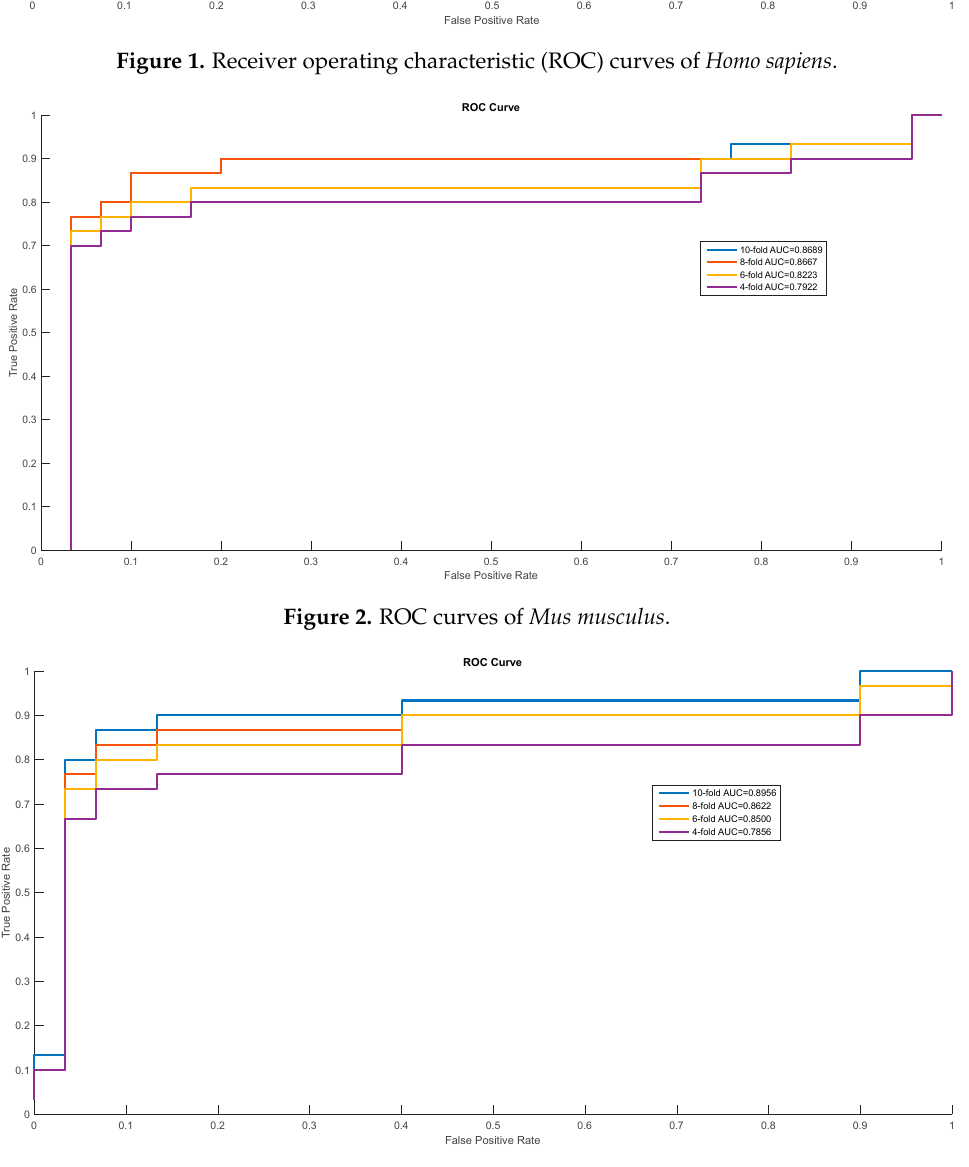
Figure 3. ROC Curves of Escherichia coli .